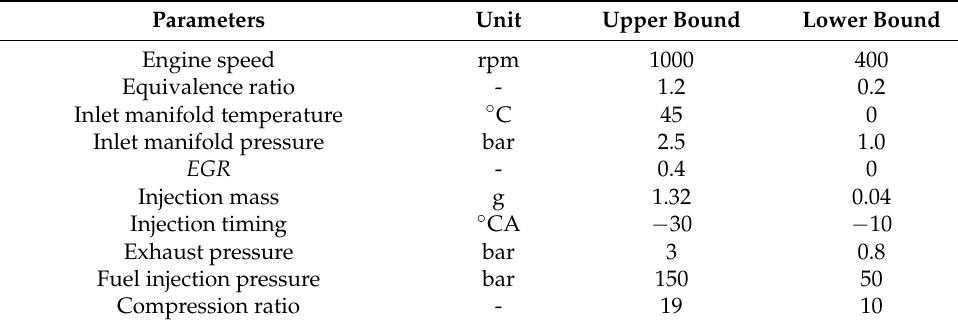
Table 5. The Upper and Lower Bounds for Data